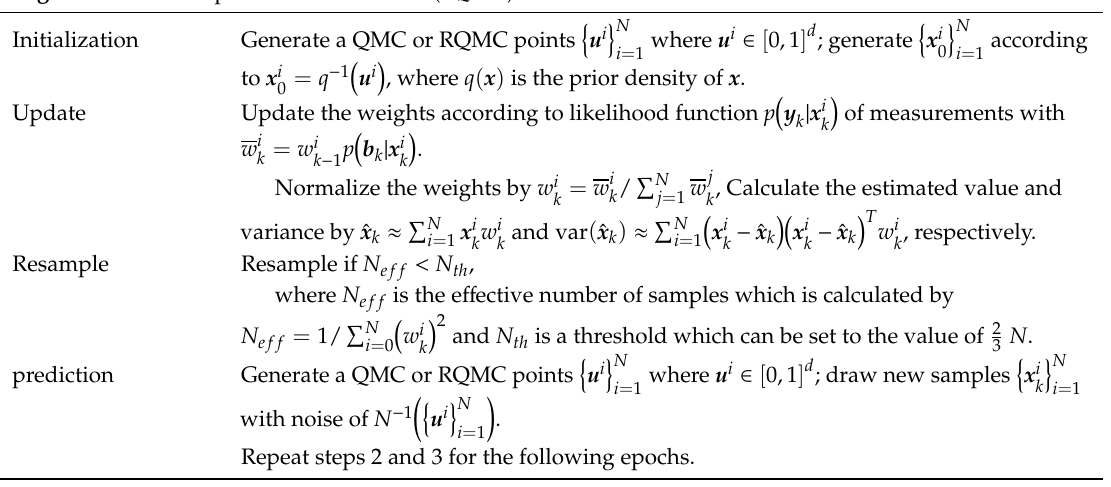
Figure 2 . Flowchart of the global navigation satellite system (GNSS) phase bias estimation. The blue boxes refer to the GNSS data processing steps and the yellow boxes are related to SQMC. Algorithm 3: GNSS phase bias estimation (SQMC)